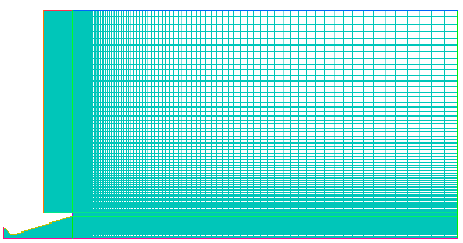
Figure 7. Schematic diagram of the entire grid area.